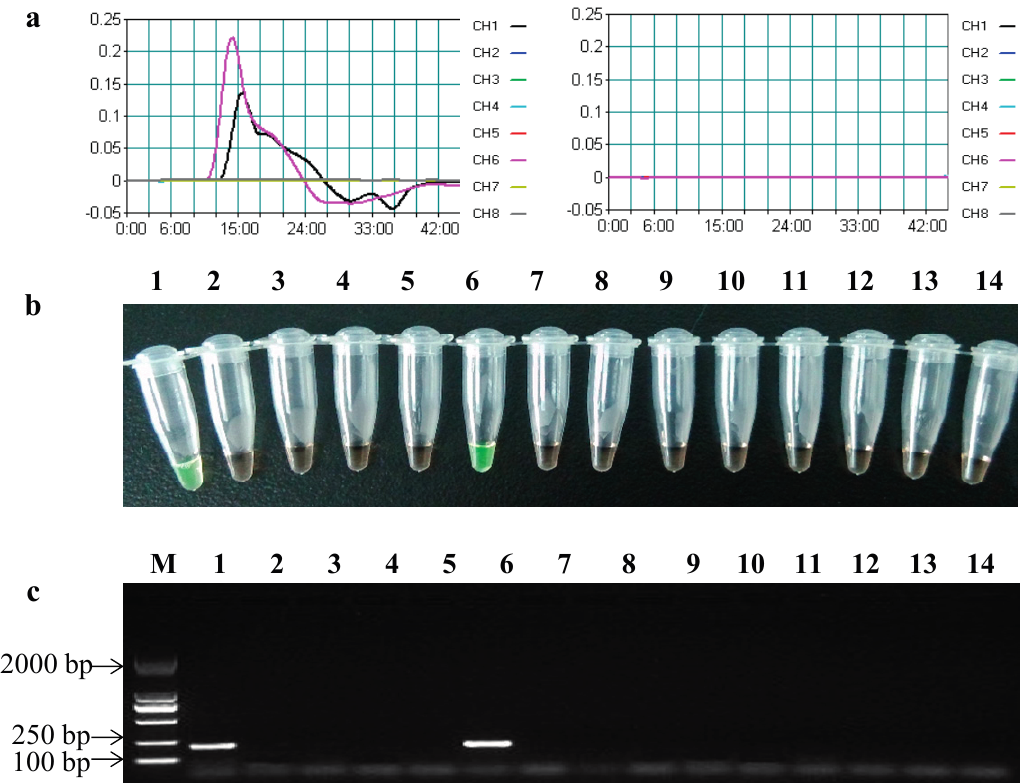
Figure 2. Specificity of the LAMP assay and conventional PCR for detecting the cry2Ab gene. ( a ) The time threshold curves of the LAMP assay observed by using the LA-320C turbidimeter. ( Right ) CH1, GM maize MON89034; CH2, GM maize MON810; CH3, GM maize Bt11; CH4, GM maize Bt176; CH5, GM cotton MON531; CH6, GM cotton MON15985; CH7, GM rice KF-6; CH8, GM rice TT51-1; ( Left ) CH1, GM maize MON863; CH2, GM maize MON88017; CH3, GM maize MIR604; CH4, GM maize TC1507; CH5, GM maize 59122; CH6, non-GM crop mixture; ( b ) The LAMP assay results using SYBR Green I dye; and ( c ) The conventional PCR results. Lane M, DL2000 DNA marker (TaKaRa Biotechnology Co., Ltd., Dalian, China); Lanes 1–14, MON89034, MON810, Bt11, Bt176, MON531, MON15985, KF-6, TT51-1, MON863,